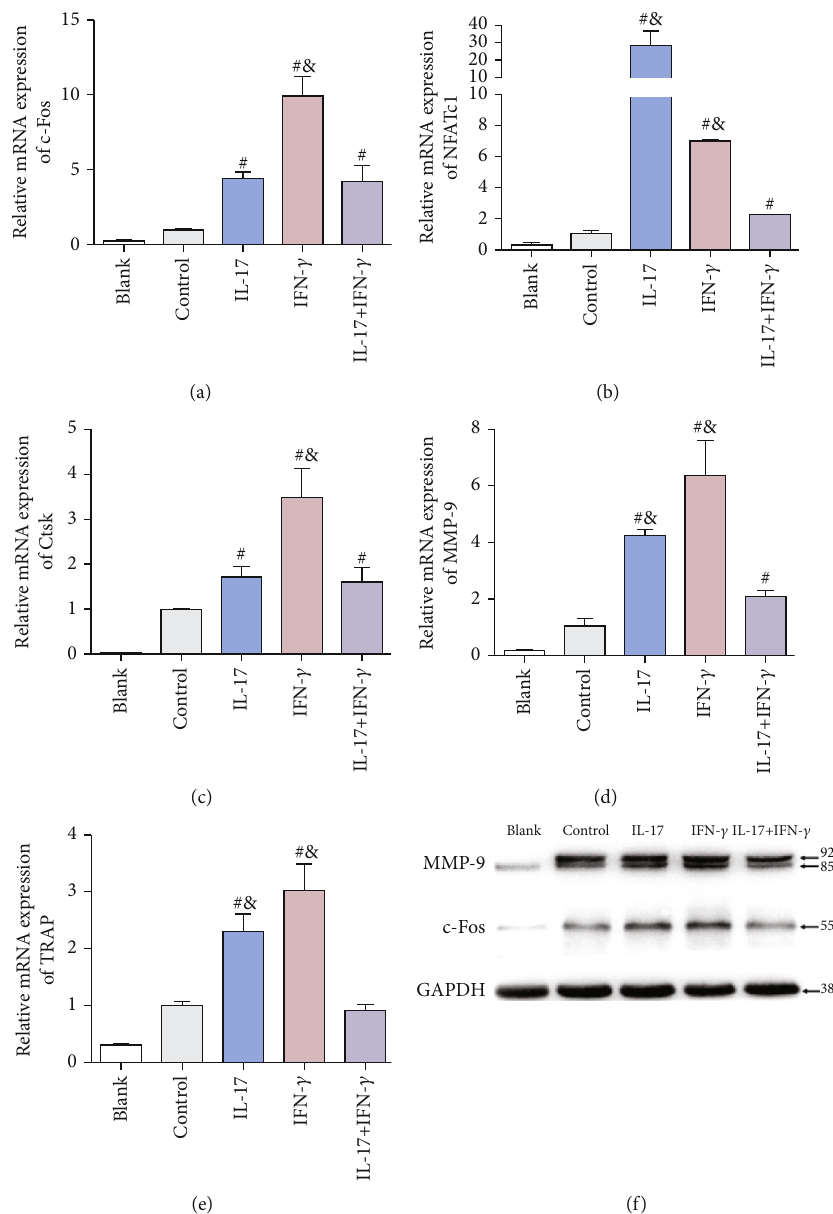
Figure 2: E ff ects of IL-17 (1 ng/ml) or/and IFN- γ (0.2 ng/ml) on the expression of osteoclastogenic genes in vitro . The mRNA expression of osteoclast-related genes (a) c-Fos, (b) NFATc1, (c) Ctsk, (d) MMP-9, and (e) TRAP was detected with di ff erent concentrations of IL-17 or/and IFN- γ using RT-qPCR. Data were standardized to GAPDH expression and shown as a fold change relative to the control group ( mean ± standard deviation , n = 3 ). # p < 0 : 05 compared with the control group; & p < 0 : 05 compared with the IL-17+IFN- γ